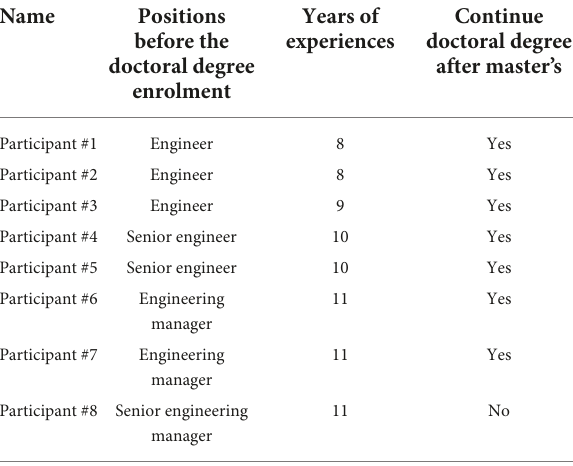
TABLE 1 Demography of the